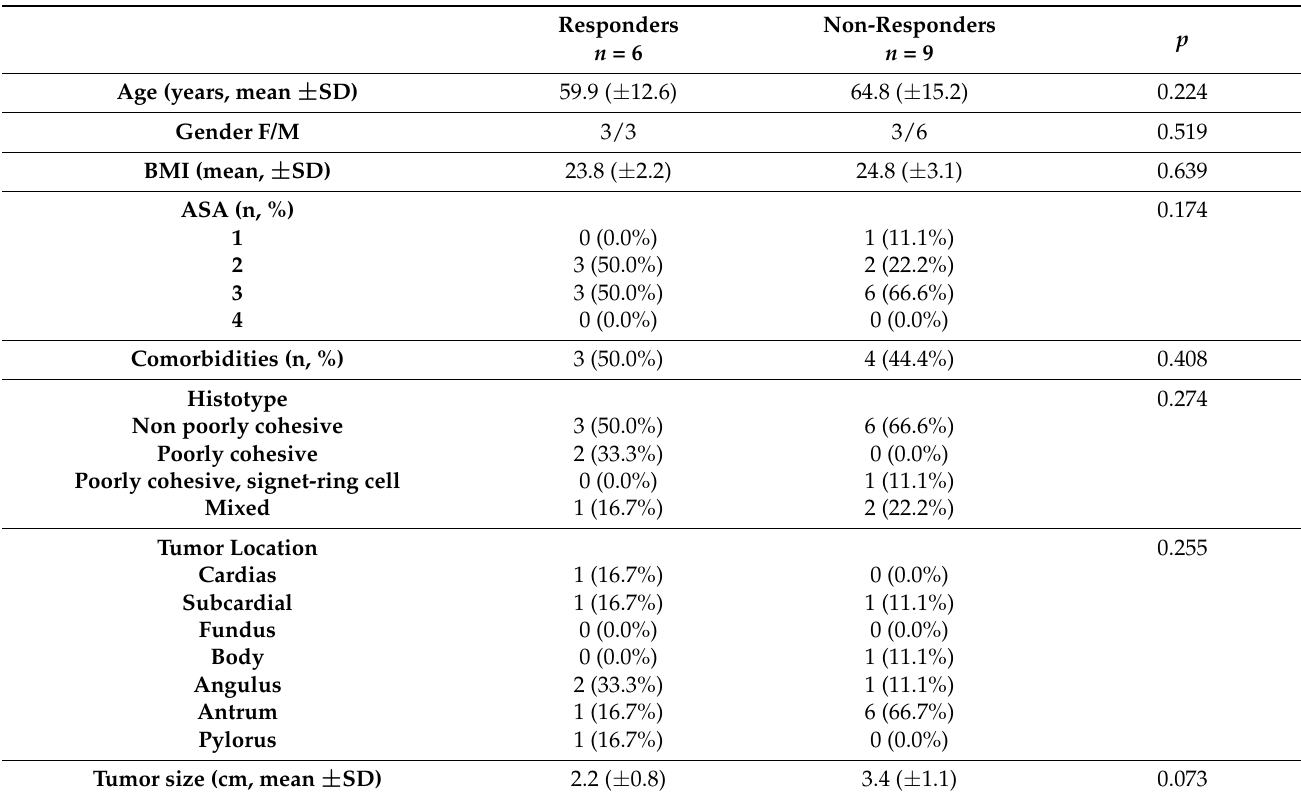
Table 1. Baseline characteristics of the included patients.